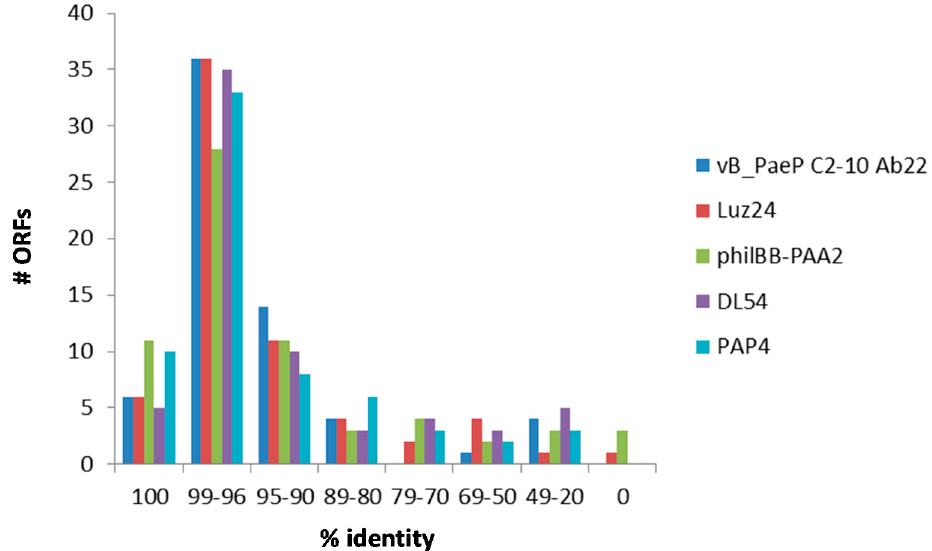
Figure 4. Sequence identity of translated ORFs of phage SL4 with five members of the LUZ24-like viruses (i.e., phages vB_PaeP C2-10 Ab22, Luz24, philBB-PAA2, DL54, and PAP4). Remaining ORFs, mostly hypothetical proteins, show even lower sequence identities.